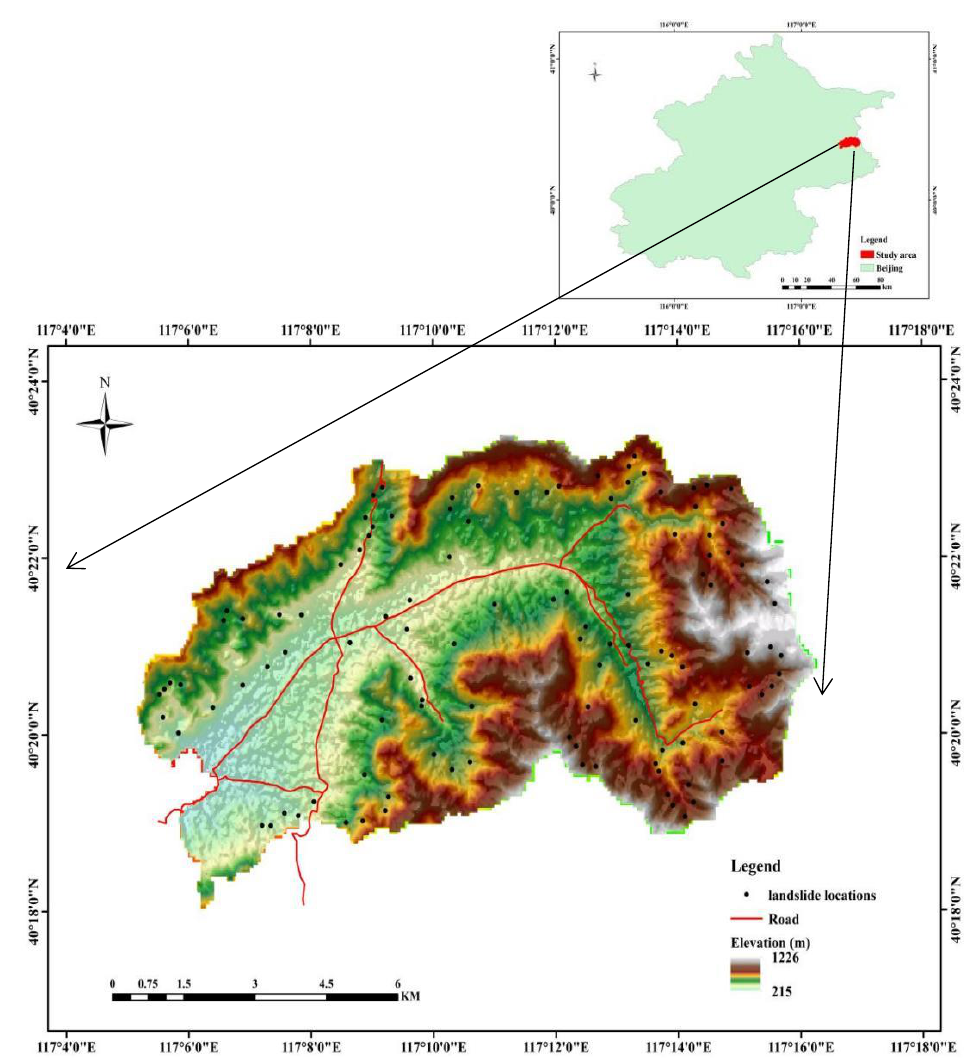
Figure 1. Geographical position of the study area showing landslide locations.